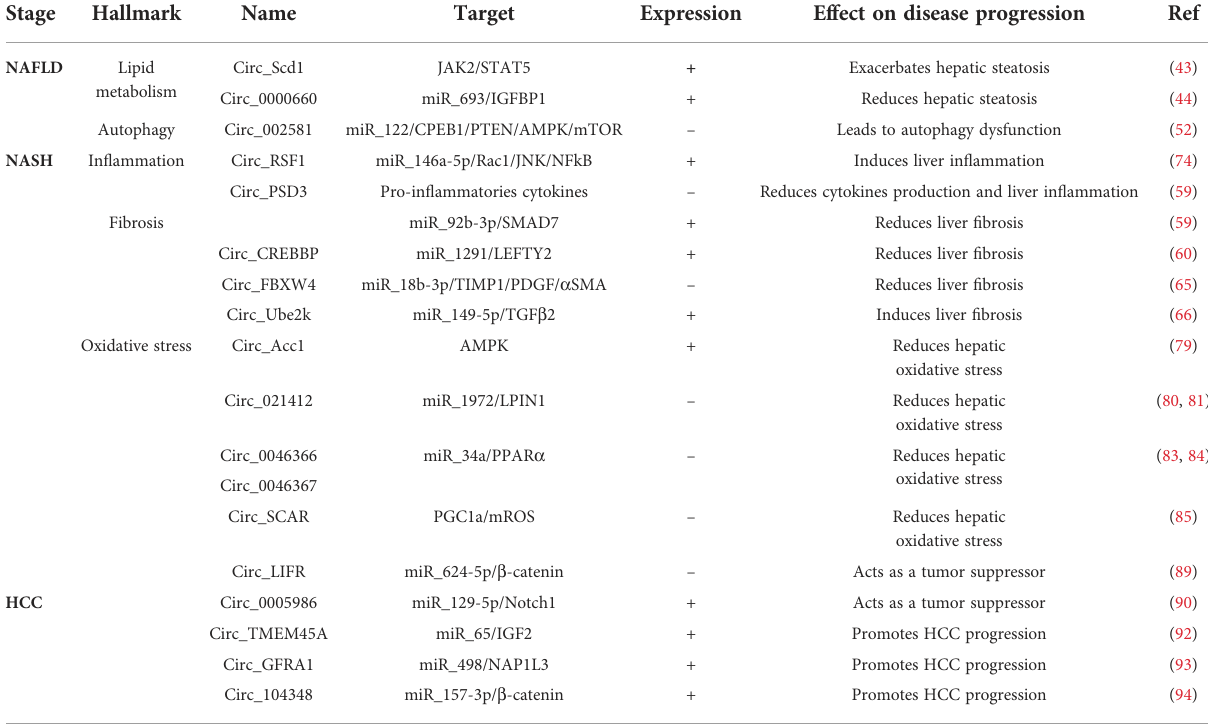
TABLE 1 Implication of cirRNAs in liver diseases: NAFLD, NASH and hepatocellular carcinomas, and their effects.